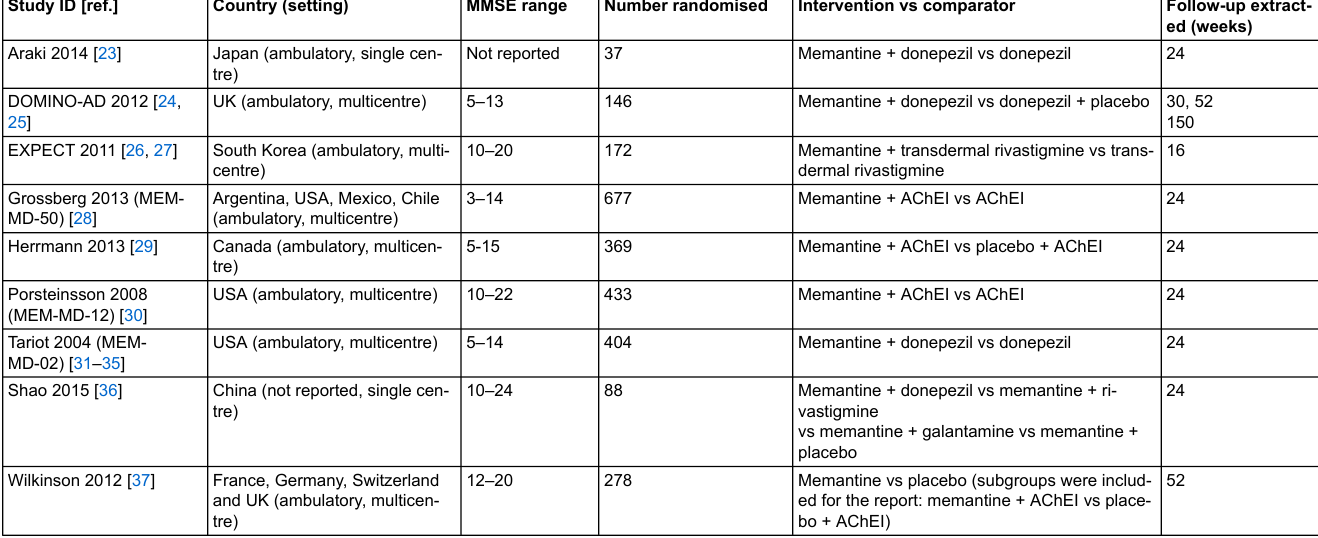
Table 1: Overview of included studies.